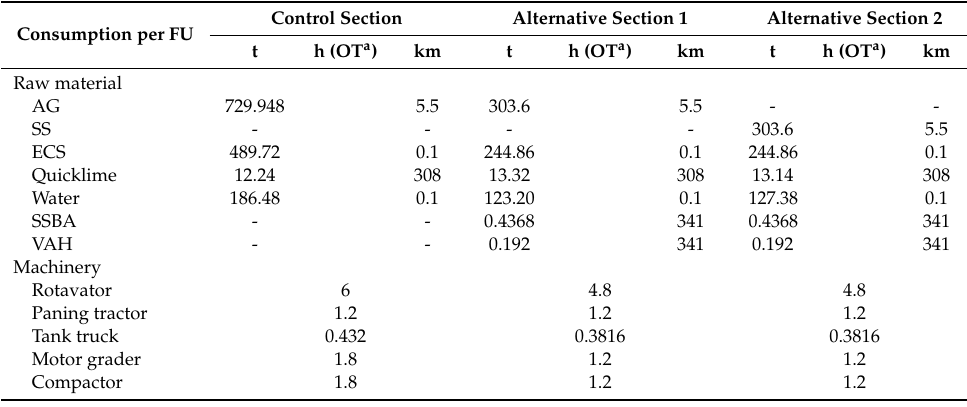
Table 8. Inventory data for executed